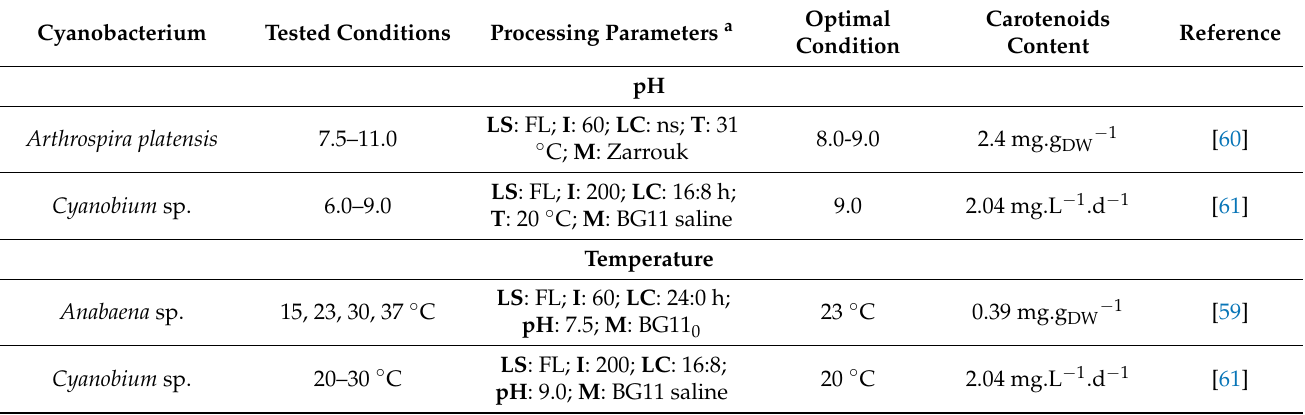
Table 3. Effects of temperature and pH on the production of carotenoids by cyanobacteria. Processing parameters include: light source (LS) and intensity (I), light:dark cycle (LC), temperature (T), pH, and culture media (M). Light intensity is expressed in µ mol photons .m − 2 .s − 1 unless another unit is